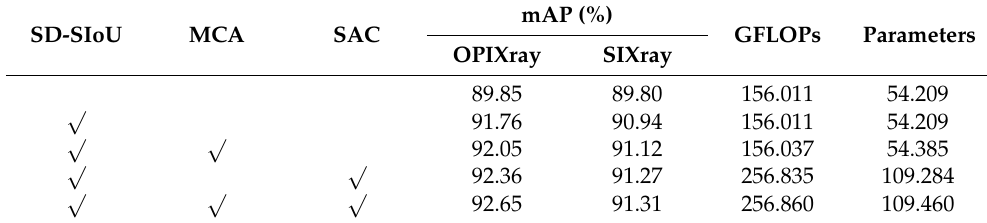
Table 5. Ablation study on OPIXray and